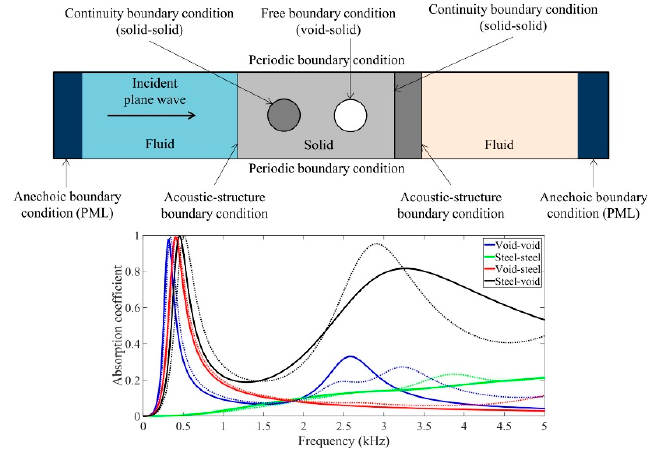
Figure 7. Acoustic coatings with hybrid structure. Schematic diagram of the numerical model and effect of steel backing plate on the sound absorption coefficient of a phononic crystal [39].